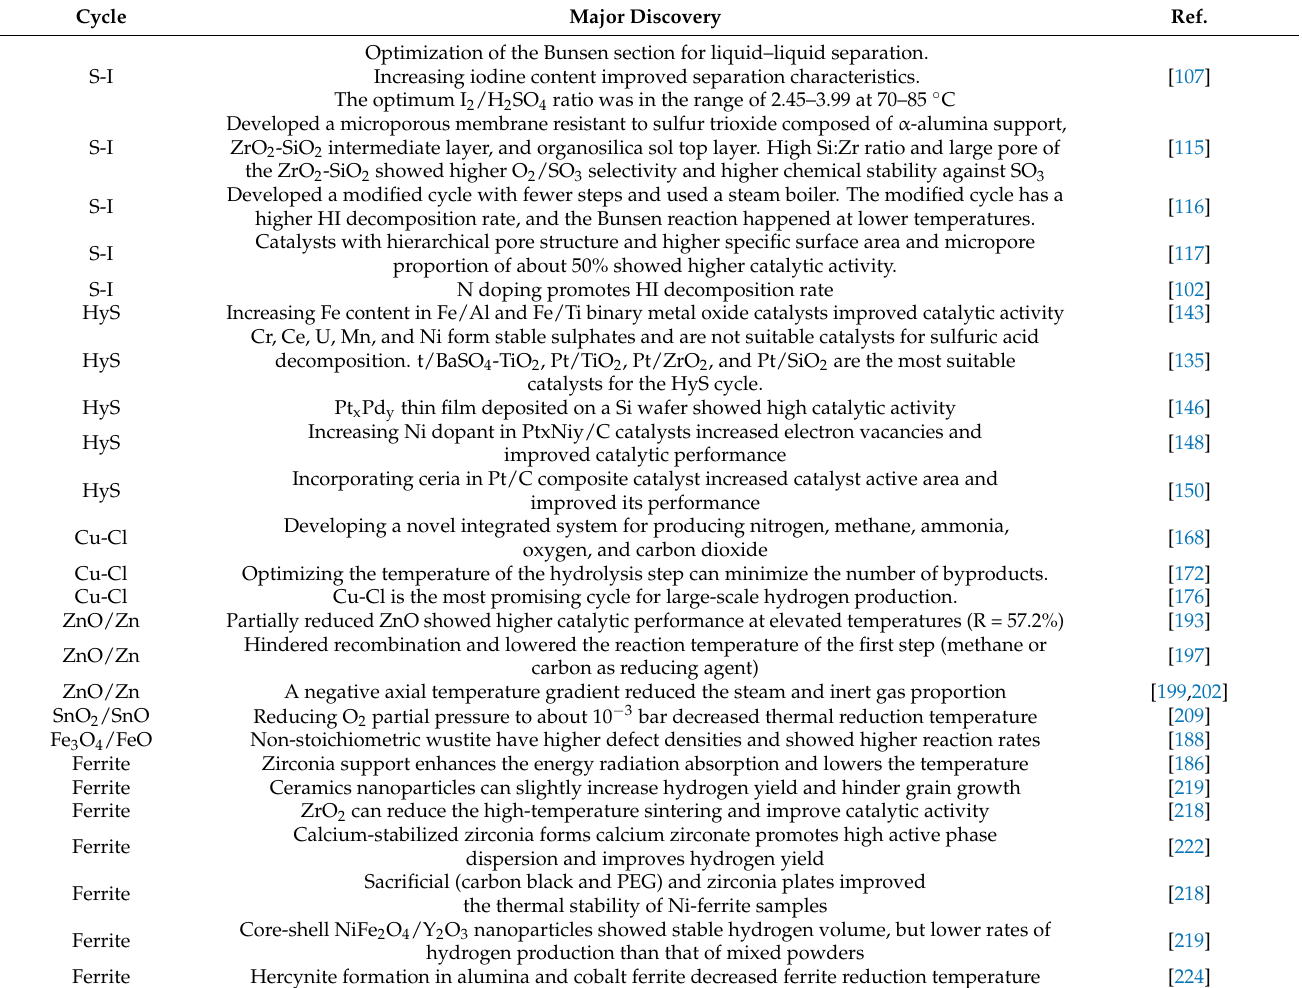
Table 3. Summary of the significant discoveries of some of the essential thermochemical water- splitting